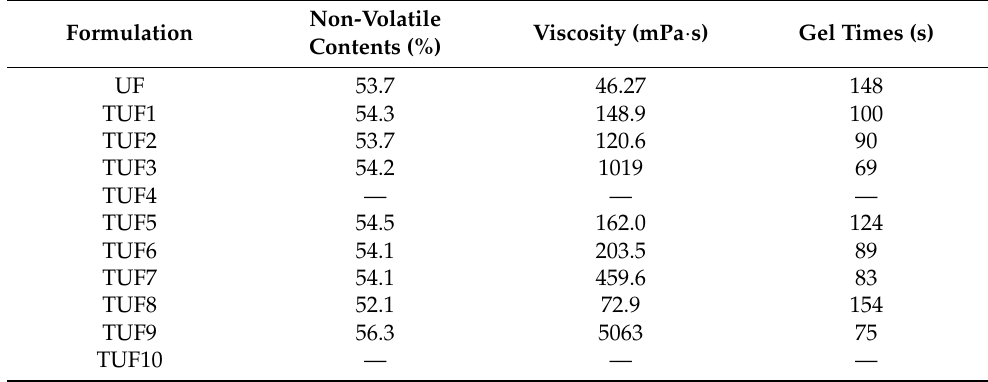
Table 4. Basic properties of TUF resins compared with UF resin. Formulation